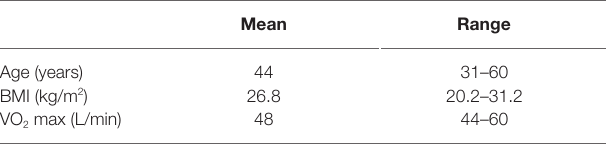
TABLE 1 | Study subject characteristics prior to saturation ( n =